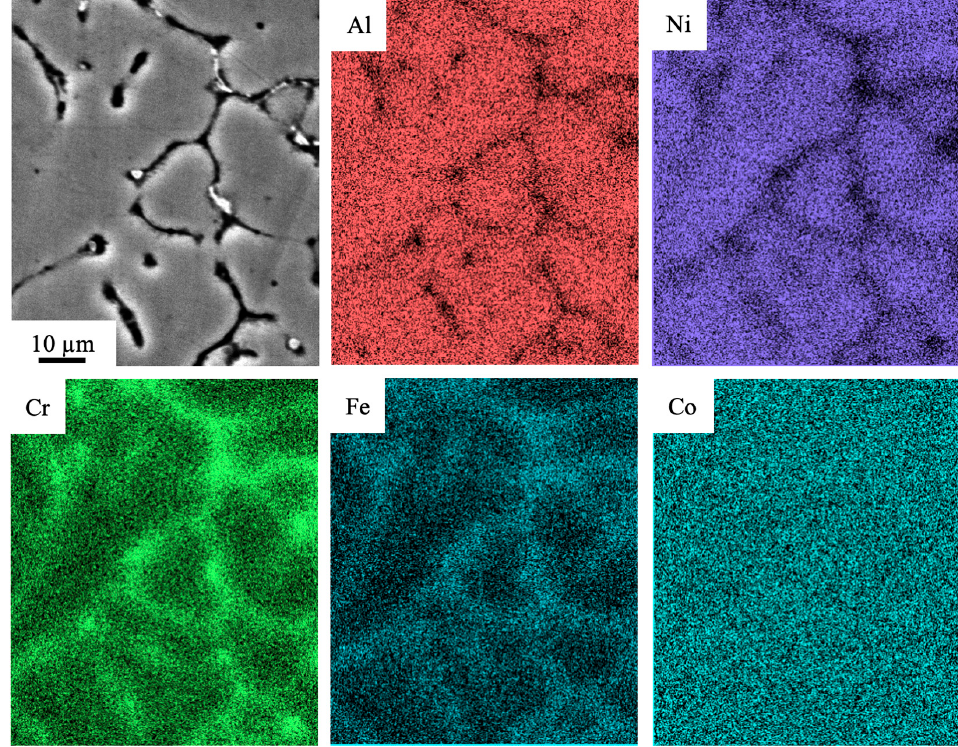
Figure 2. The SEM-EDS elemental mapping of the fabricated Al-Co-Cr-Fe-Ni HEA via wire-arc additive manufacturing.